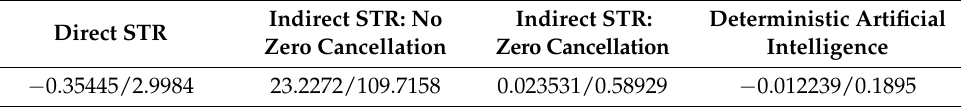
Table 3. Mean/Standard Deviation of Input Tracking Errors Corresponding to Figure